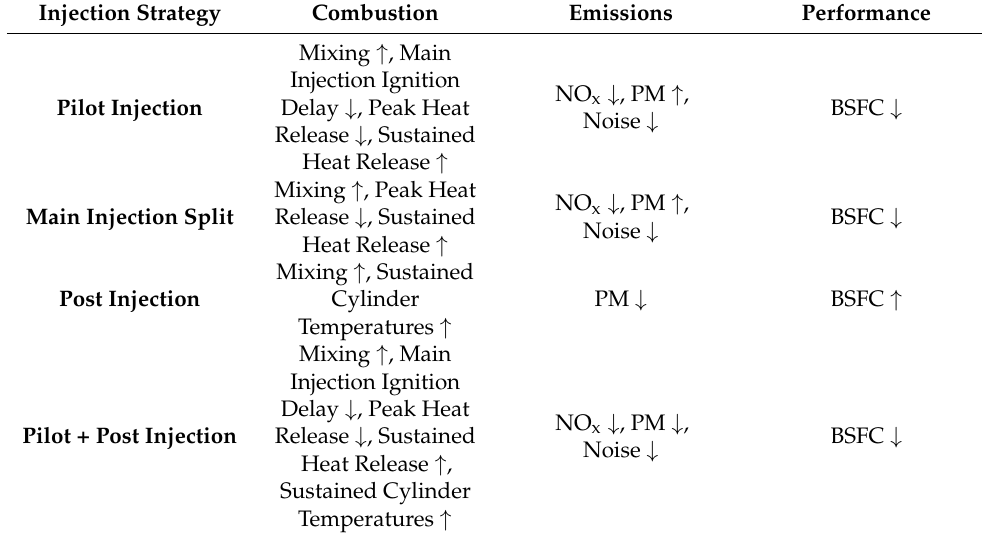
Table 1. Summary of various multiple fuel injection strategy effects using diesel and biodiesel fuels. In this table, use of ↑ and ↓ indicates the respective impact of that injection strategy on the parameter mentioned by either increasing or decreasing the